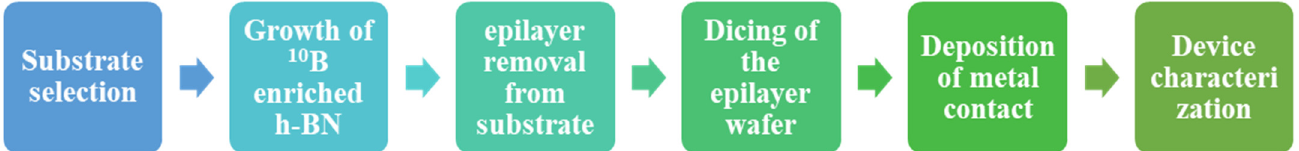
Figure 1. h-BN stacked structure (the image is reproduced from [40], copyright 2012, with permis- sion from SPIE).